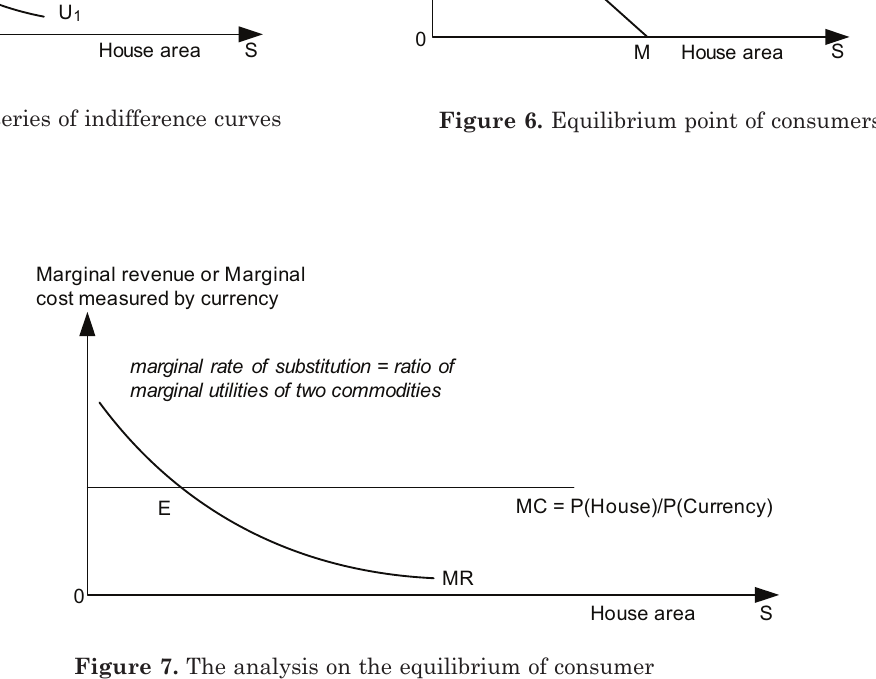
figure 7. The analysis on the equilibrium of